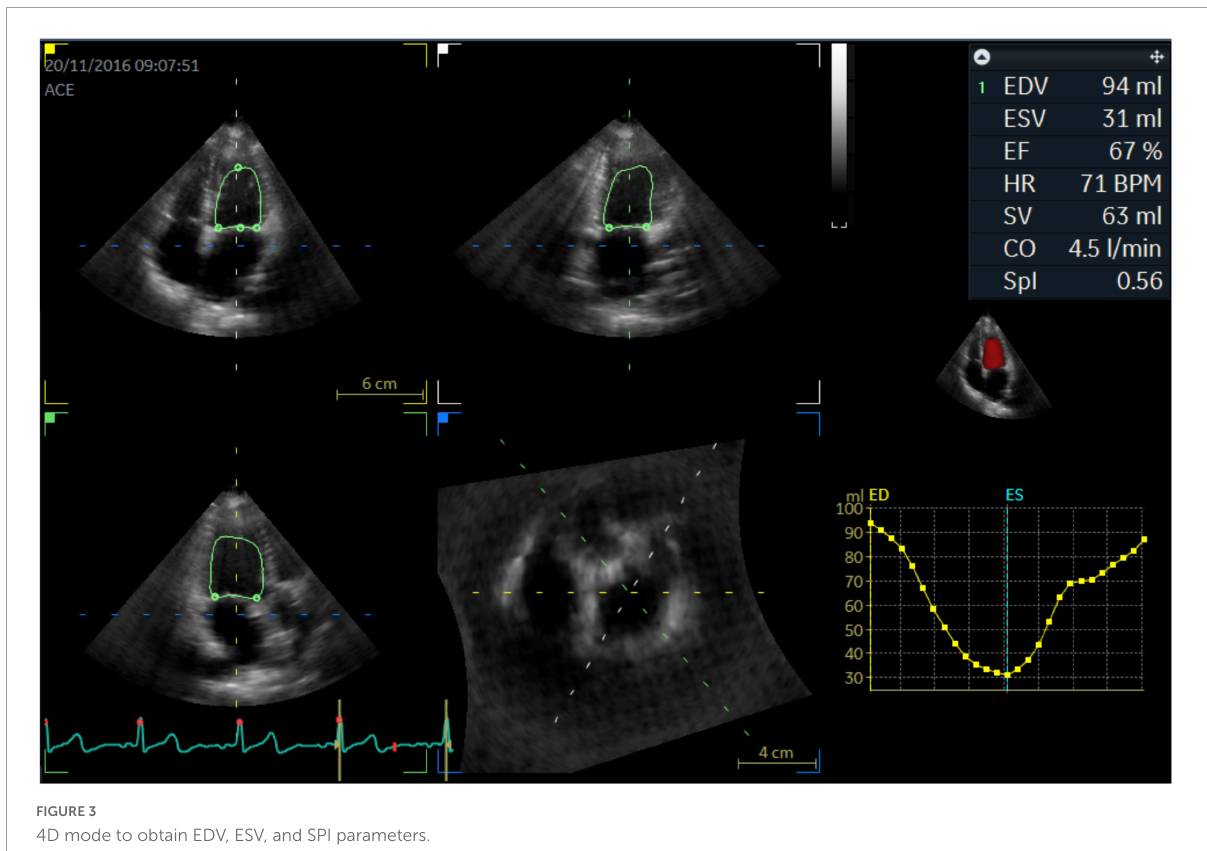
FIGURE3 4D mode to obtain EDV, ESV, and SPI parameters.